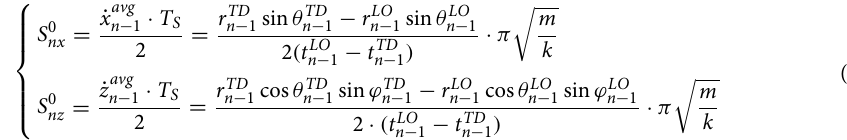
represent actual leg